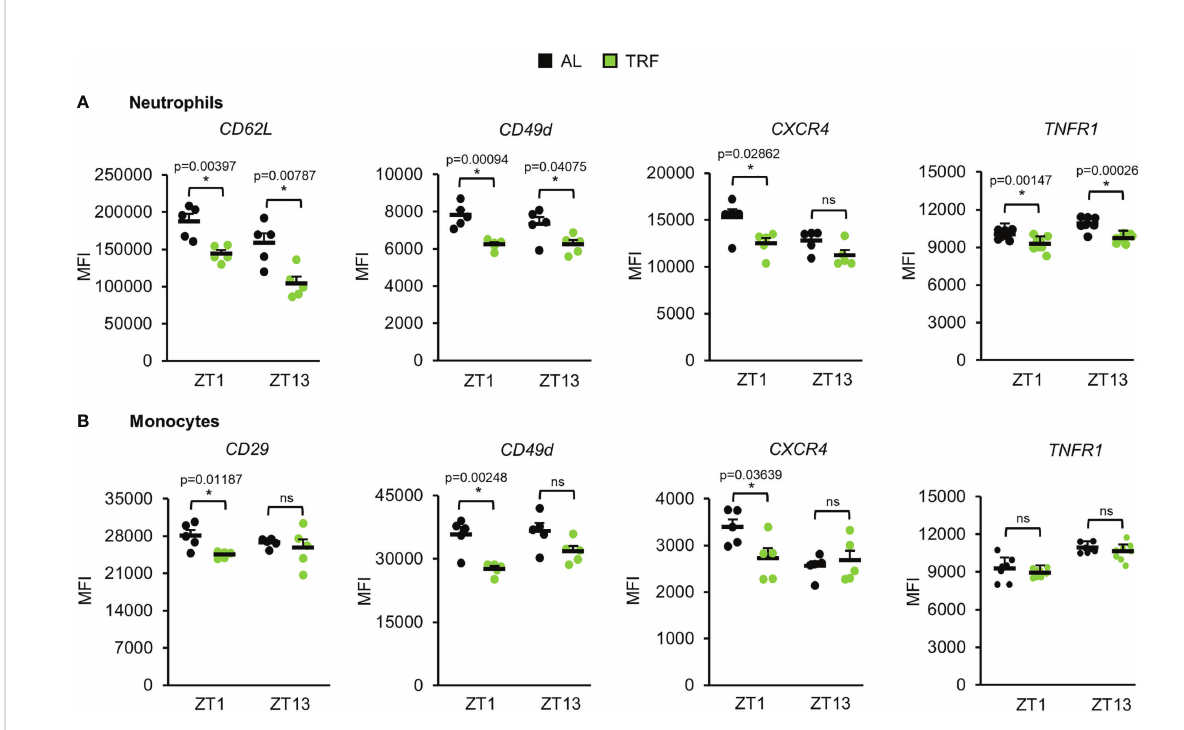
FIGURE 6 Time restricted feeding modulates the expression of adhesion molecules and cytokine receptors of peripheral neutrophils and monocytes. Selectin (CD62L), integrin (CD29, CD49d) and cytokine receptor (CXCR4, TNFR1) expression of neutrophils (A) and monocytes (B) at ZT1 and ZT13 (mean + SEM, n = 5 (AL), n = 5 (TRF), two-sample t-test, * p < 0.05). ZT, Zeitgeber time. Histograms of fl uorescence intensities are shown in Supplementary Figure 9 ns, not signi fi